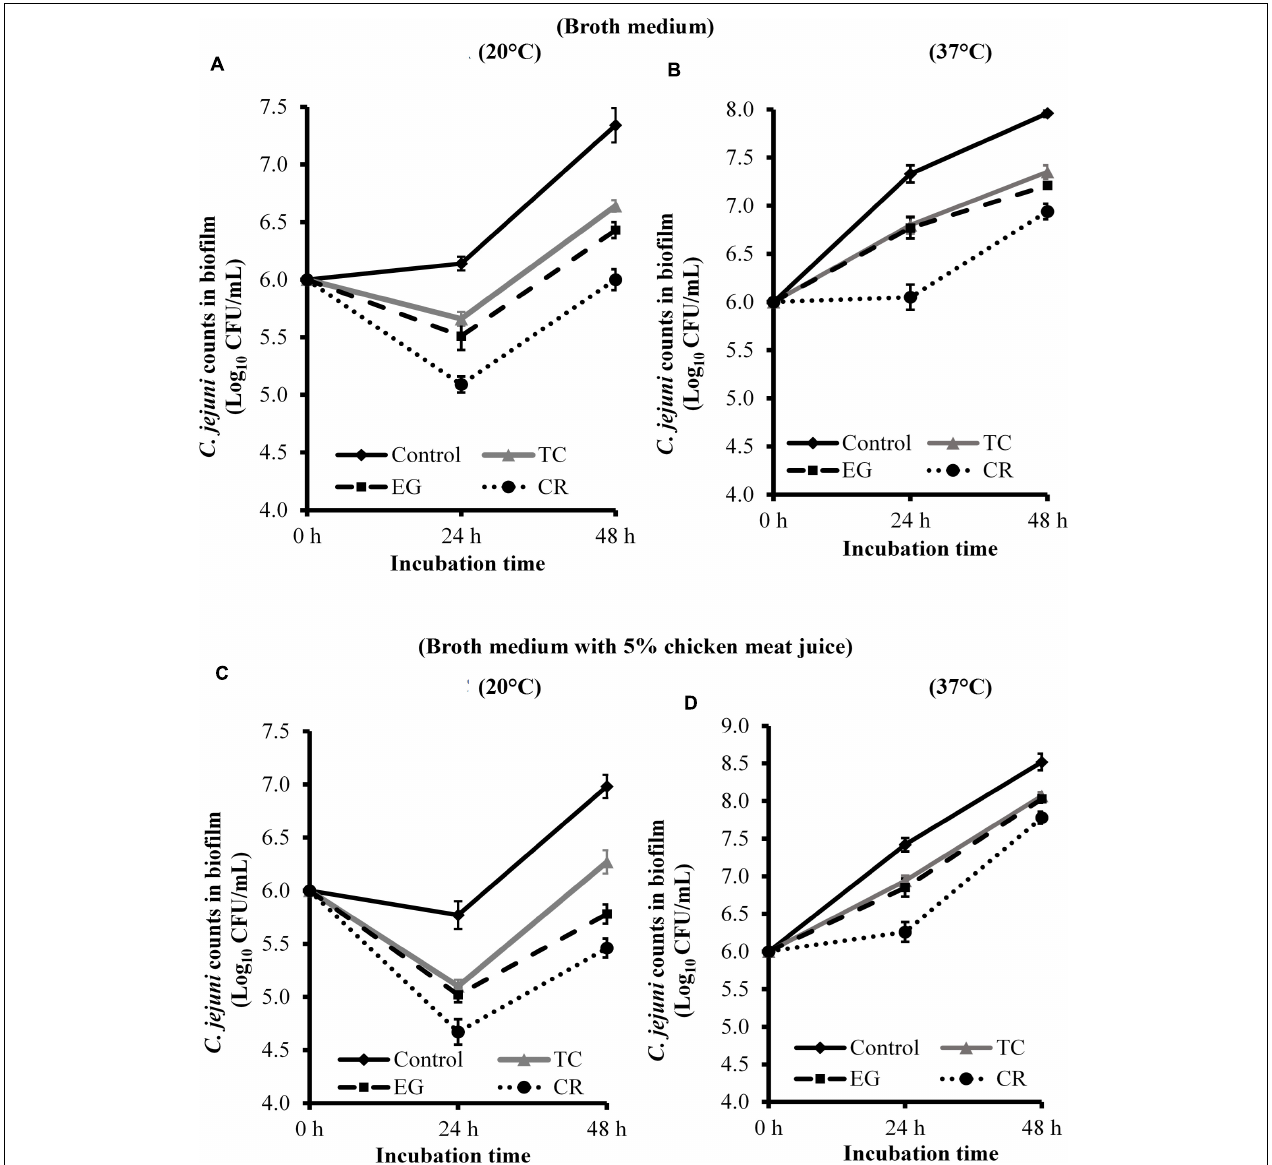
FIGURE 2 | Effect of SICs of trans -cinnamaldehyde (TC), eugenol (EG), and carvacrol (CR) on Campylobacter jejuni NCTC 11168 biofilm formation on polystyrene plates in the broth medium (A,B) and in the presence of 5% chicken meat juice (C,D) . Error bars represent SEM ( n = 6). C. jejuni ( ∼ 6.0 Log CFU/mL) in the presence of TC (0.75 mM), EG (0.61 mM), or CR (0.13 mM) was incubated to form biofilm in sterile 96-well plates at 20 ◦ C (A,C) or 37 ◦ C (B,D) . The number of C. jejuni in the biofilm was enumerated at 24 or 48 h. All treatments were significantly different from control at both 24 and 48 h ( P < 0.05).